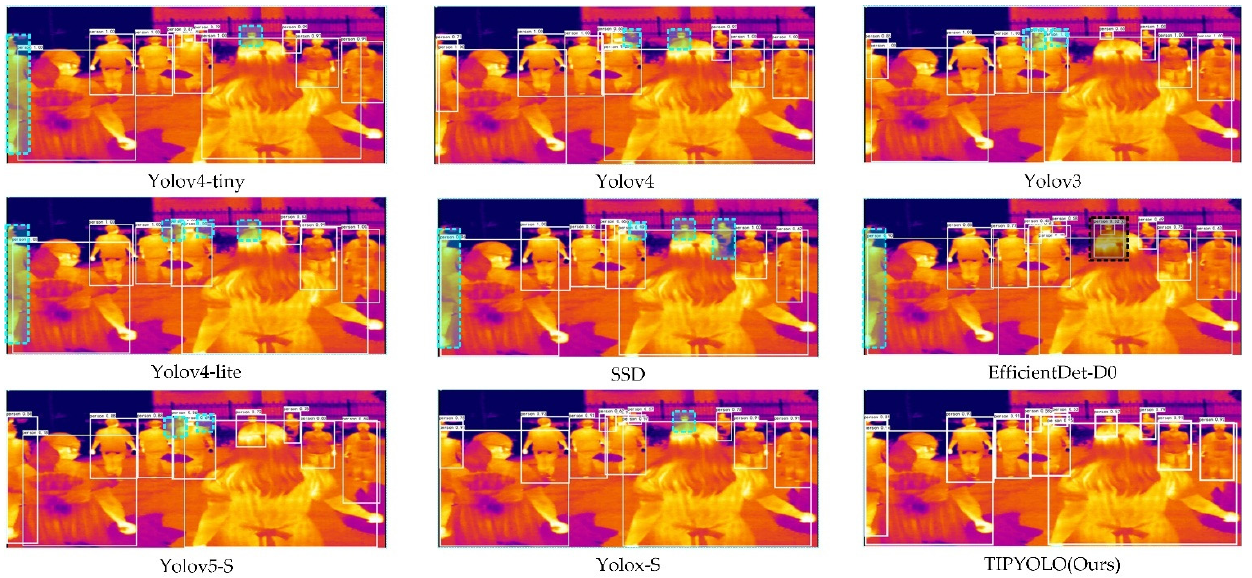
Figure 10. The detection results of YIPYOLO and other methods on the YDTIP dataset. The blue dotted boxes represent missed detections; the black dotted boxes represent false-positive detections.